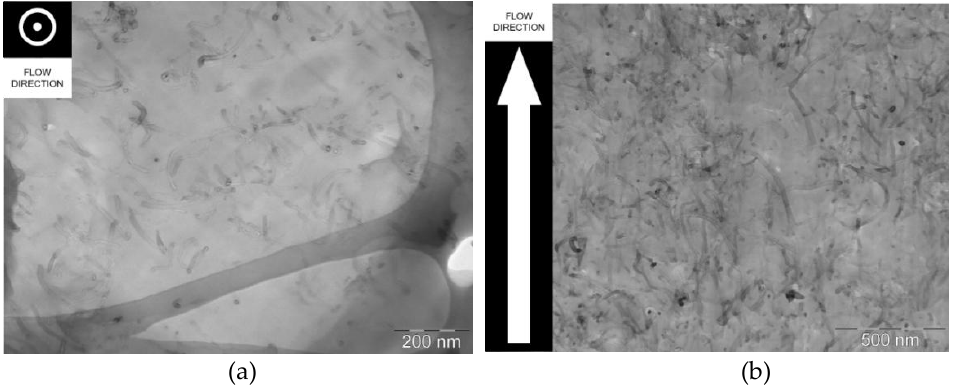
Figure 9. TEM micrograph of ABS/CNT nanocomposite filament: ( a ) Perpendicular and ( b ) parallel.